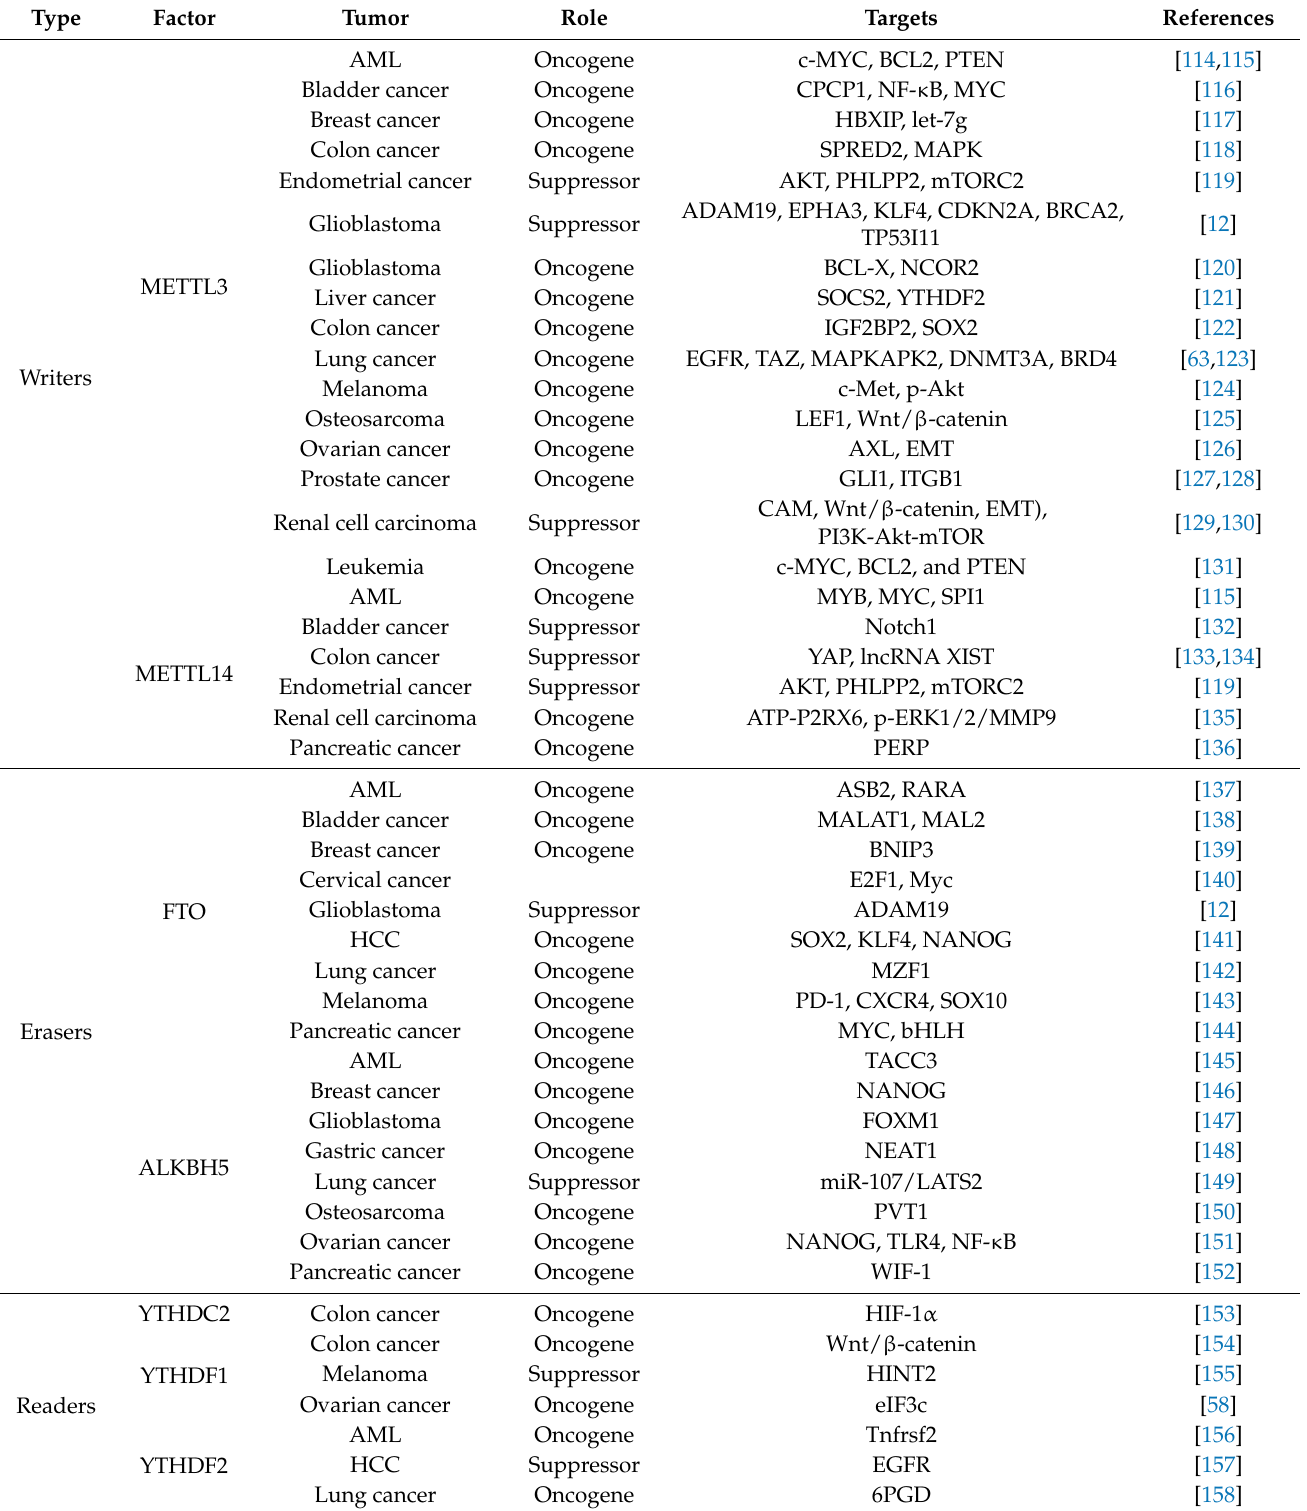
Table 2. Role of m 6 A in cancer. YTHDC1—YTH domain-containing 1; YTHDC2—YTH domain- containing 2; METTL3—methyltransferase-like 3; ALKBH5—alkB homolog 5; FTO—fat mass and obesity-associated gene; AML—acute myeloid leukemia; HCC—hepatocellular carcinoma; GSC— glioma stem